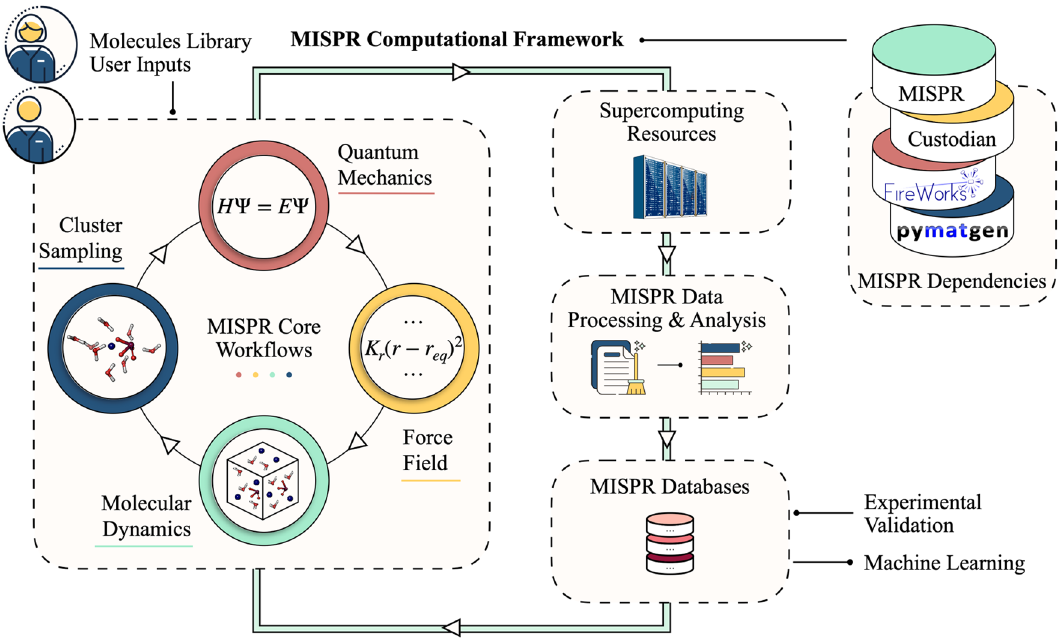
Figure 1. An overview of MISPR infrastructure. Users may choose to integrate several MISPR components to derive a specific materials property and design optimal or novel